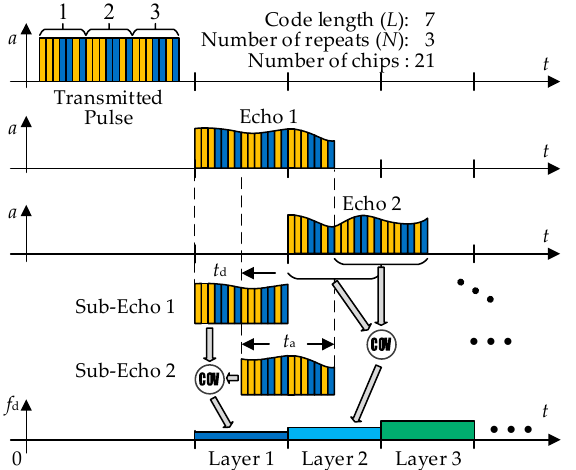
Figure 1. Velocity estimation principle of broadband Doppler sonar.